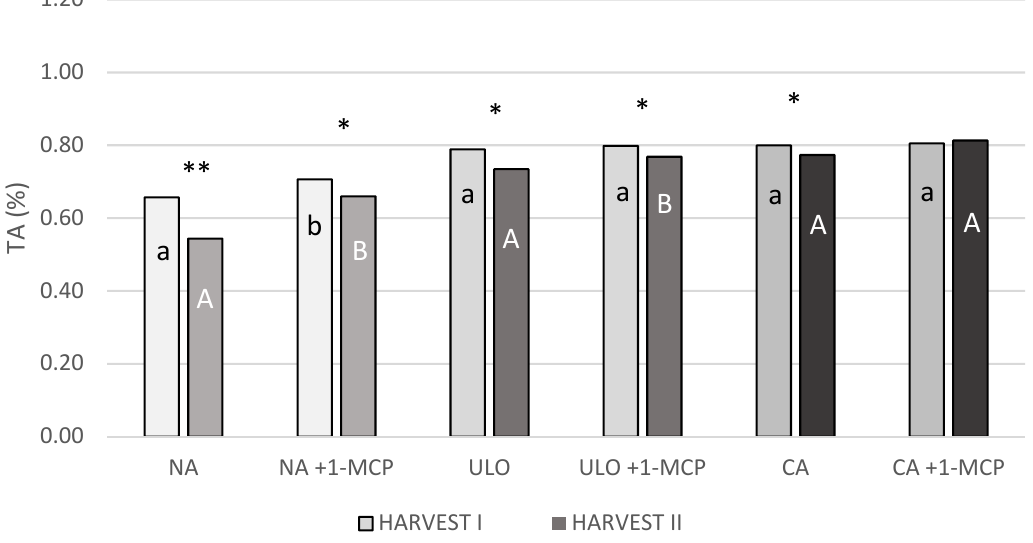
Figure 5. Titratable acidity of ‘Geneva’ fruit (%) depending on harvest time and 1-MCP treatment under three storage technologies. Statistically significant difference between first and second har- vest fruit (Newman–Keuls range test): **—for 1%. Different letters were assigned to statistically sig- nificant differences when comparing the effect of 1-MCP, separately for storage conditions.